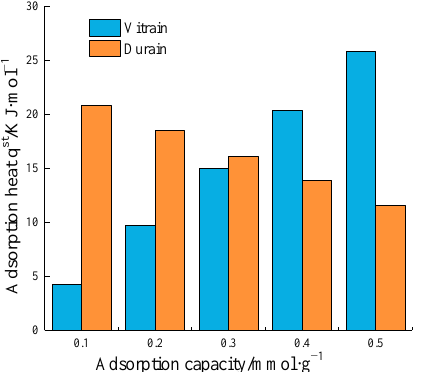
Figure 12. Comparison of adsorption heat difference between vitrain and durain during adsorption and desorption.